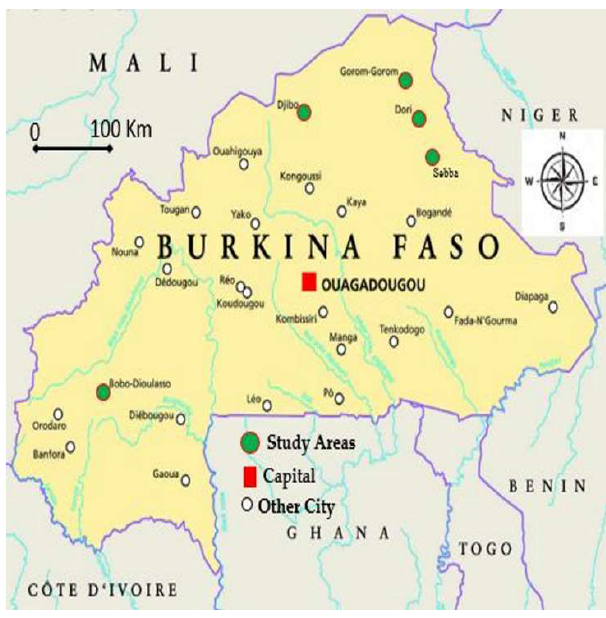
Figure 9. Location of study areas.